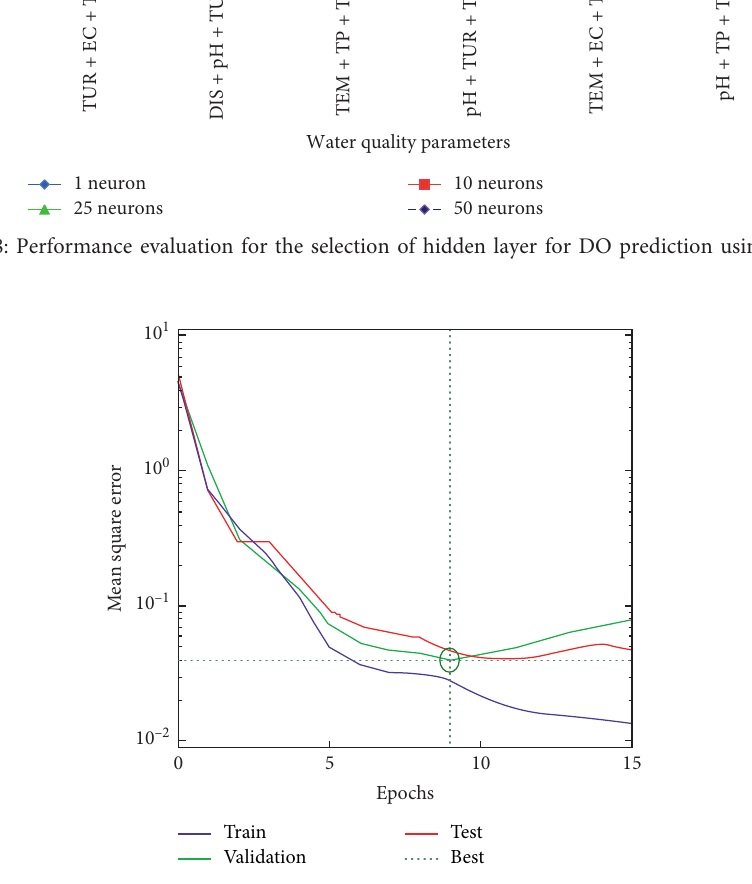
Figure 9: Training of the RNN